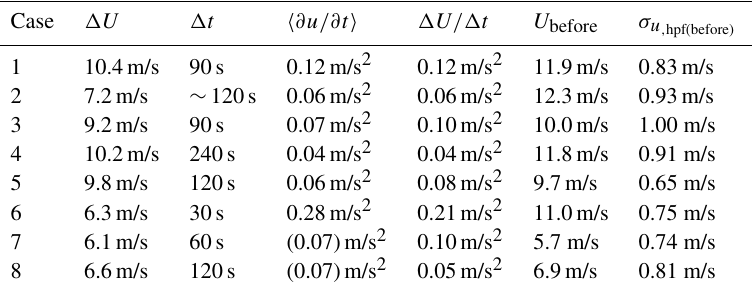
Table 2. Diagnosed parameters from ensemble of constrained (CMM) simulations; ramp acceleration is shown both as average acceleration over the ramp event ( (cid:104) ∂u/∂t (cid:105) including turbulence) and based on ratio of (cid:2) (cid:104) U after (cid:105)−(cid:104) U before (cid:105) (cid:3) to ramp duration (cid:49)t .